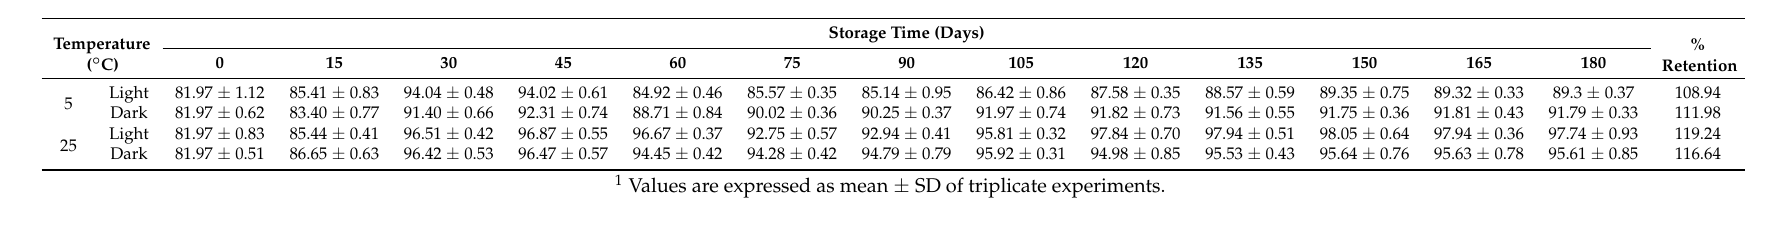
Table 4. Stability profile of eugenol under different storage temperatures and light for 180 days.